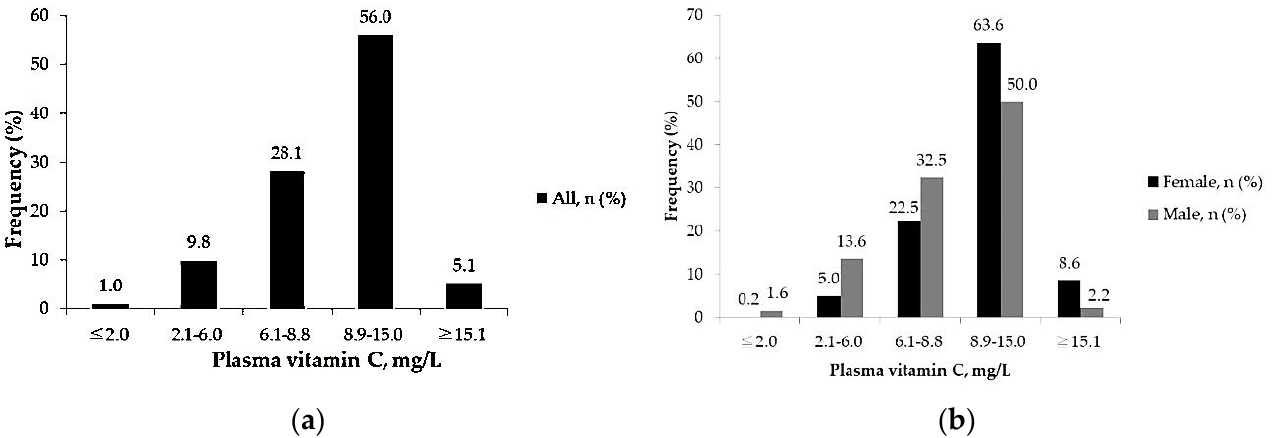
Figure 1. ( a ) Distribution of plasma vitamin C concentrations among all adults in a subtropical region; ( b ) Distribution of plasma vitamin C concentrations in female and male adults in a subtropical region.